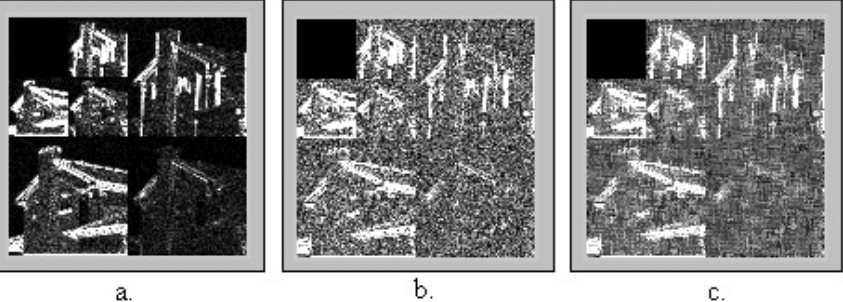
Figure 3. Hierarchical correlation maps obtained by the method proposed by Y. Li and C. Moloney in the case of the House image, 256 × 256 pixels. ( a ) Hierarchical correlation map obtained in the case of the original image, not degraded by noise. ( b ) Hierarchical correlation map obtained in the case of the degraded image with Gaussian additive white noise with dispersion σ = 0.05, (PSNR = 26.00 dB). ( c ) Hierarchical correlation map obtained by processing the map from point b with a median-hybrid type filter.